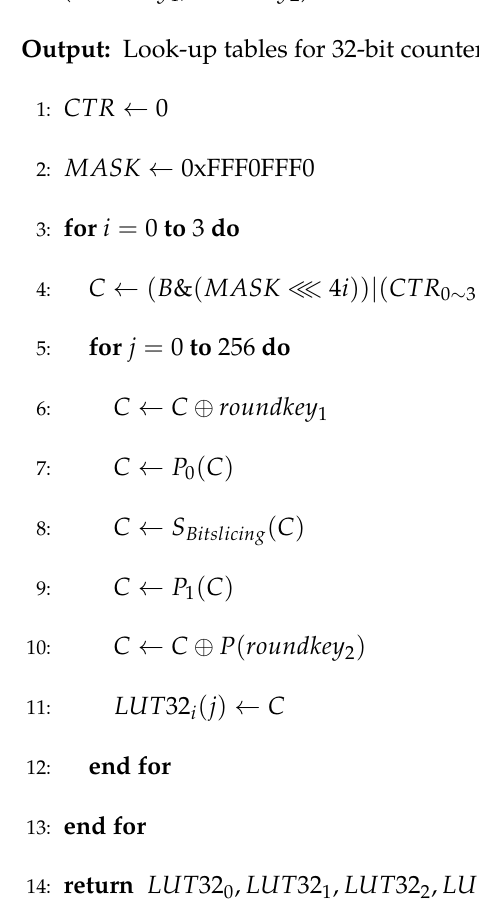
Algorithm 6: Generation of look-up tables for proposed PRESENT-CTR32 en-